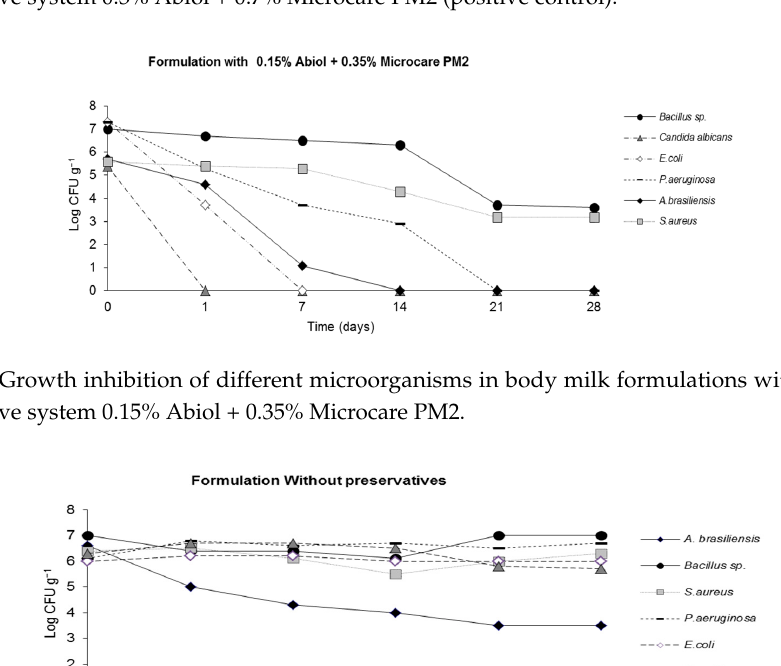
Figure 4. Growth inhibition of different microorganisms in body milk formulations with synthetic preservative system 0.3% Abiol + 0.7% Microcare PM2 (positive control).